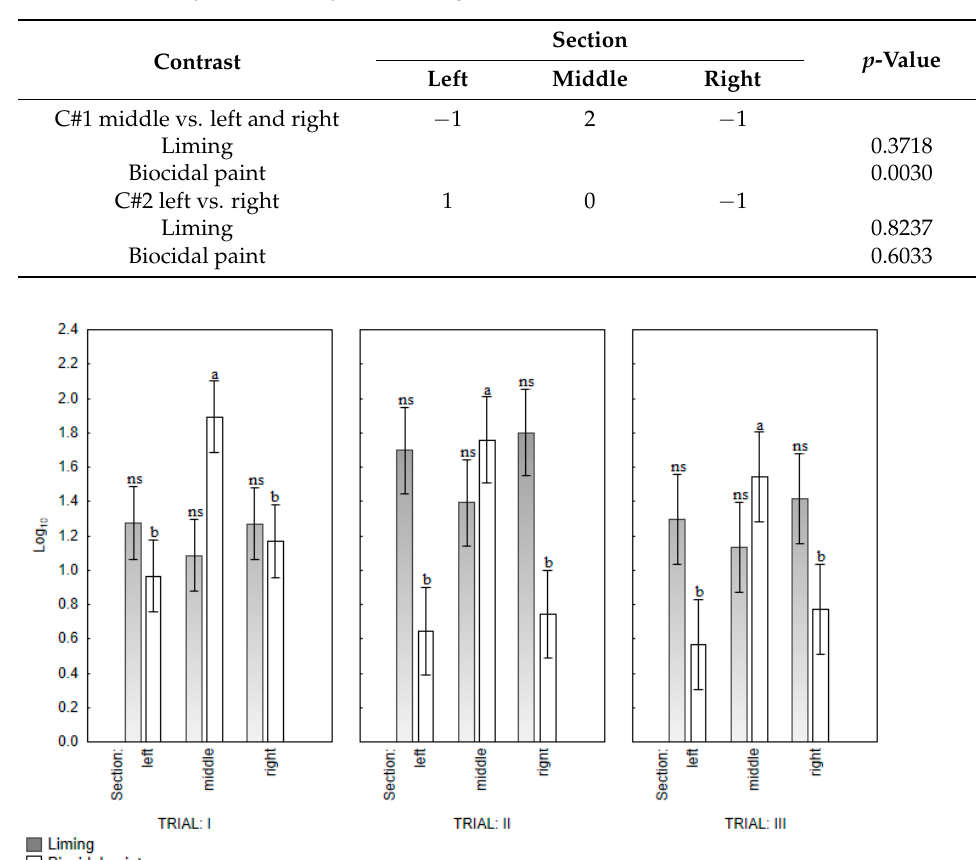
Table 3. Section-by-section analysis of orthogonal contrasts.